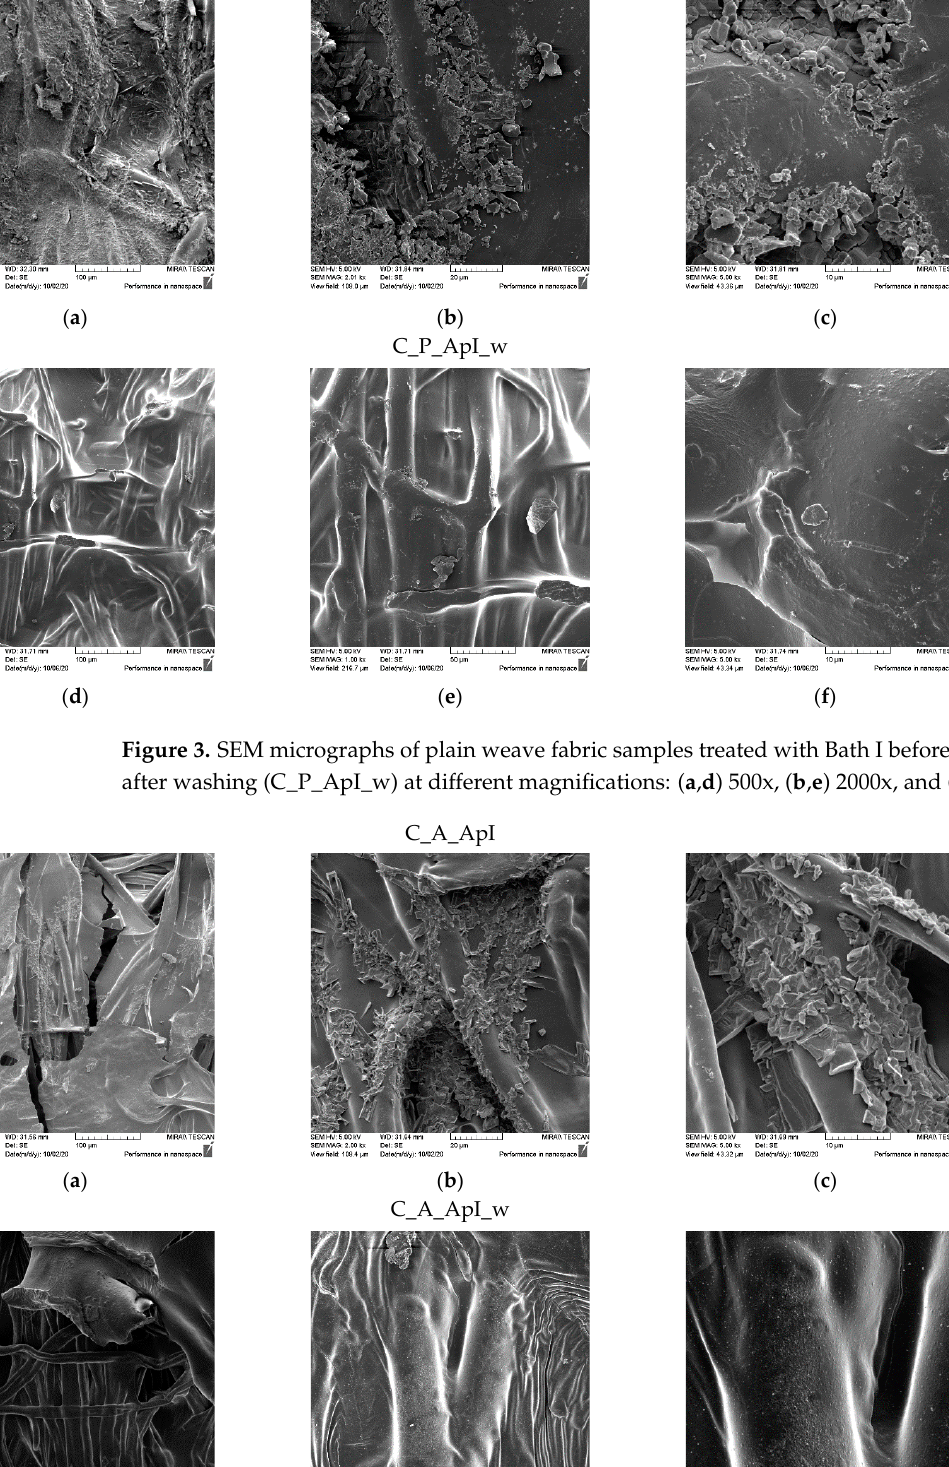
Figure 2. SEM micrographs of untreated satin weave cotton fabric at different magnifications: ( a ) 500x, ( b ) 1000x, and ( c ) 2000x.